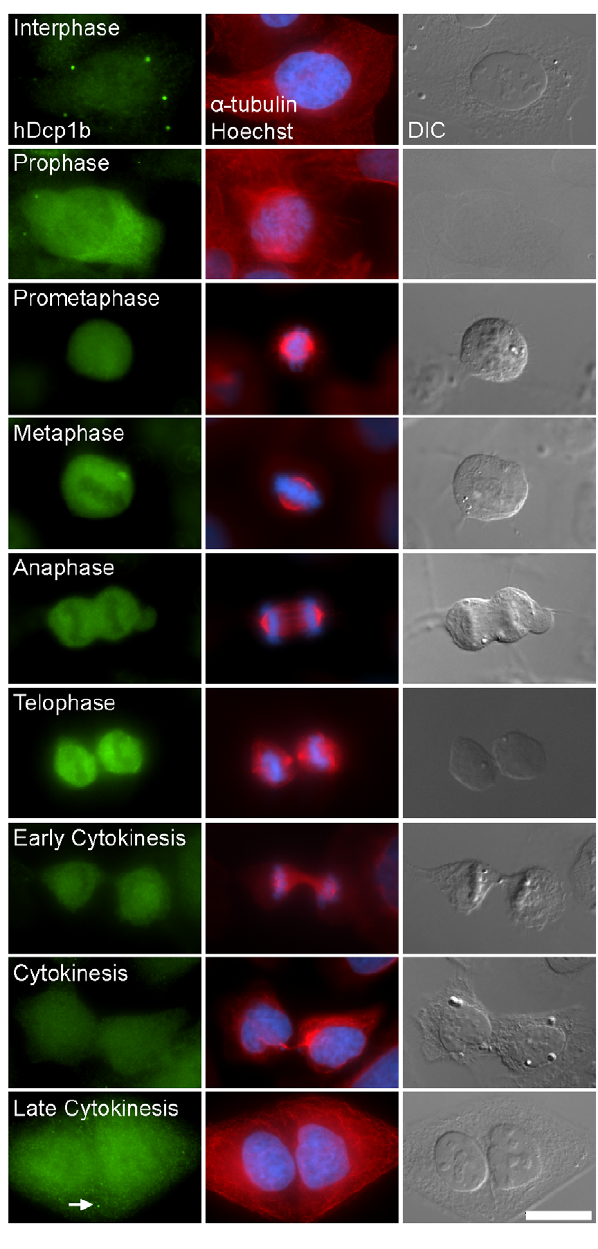
Figure 1. PB assembly and disassembly during the cell cycle. Immunofluoresence staining of endogenous hDcp1b (green), a -tubulin (red), DNA (Hoechst, blue) and DIC images show that PB structures disassemble during cell division. (Bar 20 m m).